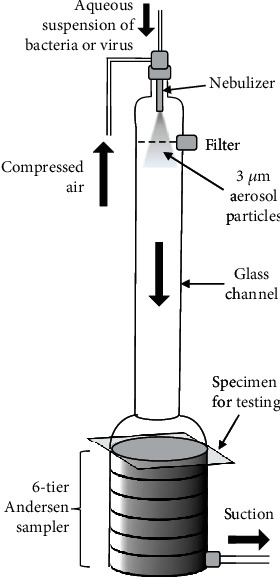
Design of the setup for evaluating BFE and VFE of mask materials using a six-stage Andersen sampler.